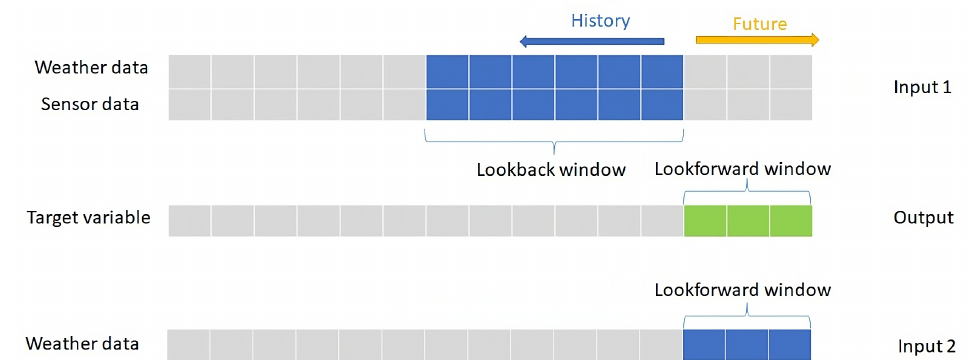
Figure 4. The relationship between input data and output data from time